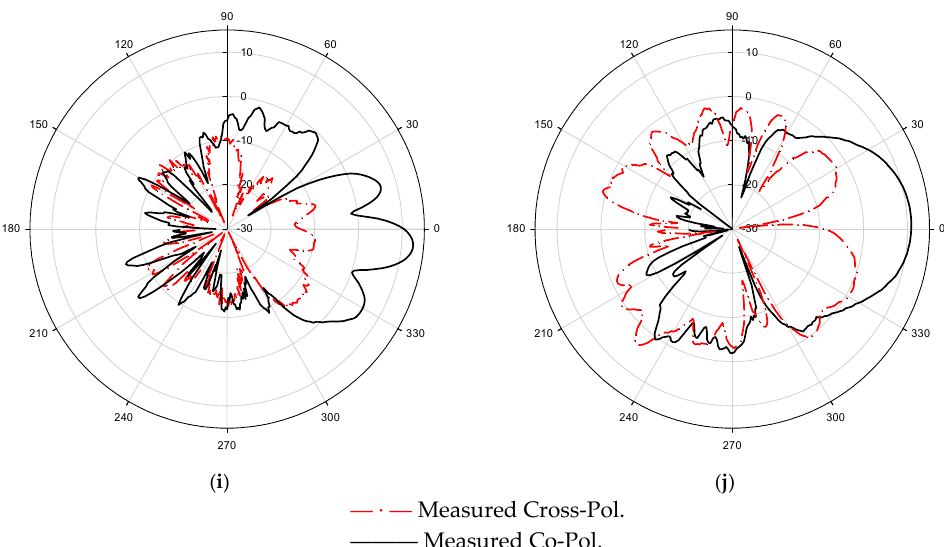
――― Measured Co-Pol. Figure 5. Measured far-field radiation pattern at E-plane ( a , c , e , g , i ) and H-plane ( b , d , f , h , j ) at frequency 3, 4, 5.5, 7, 8.5 GHz, respectively.